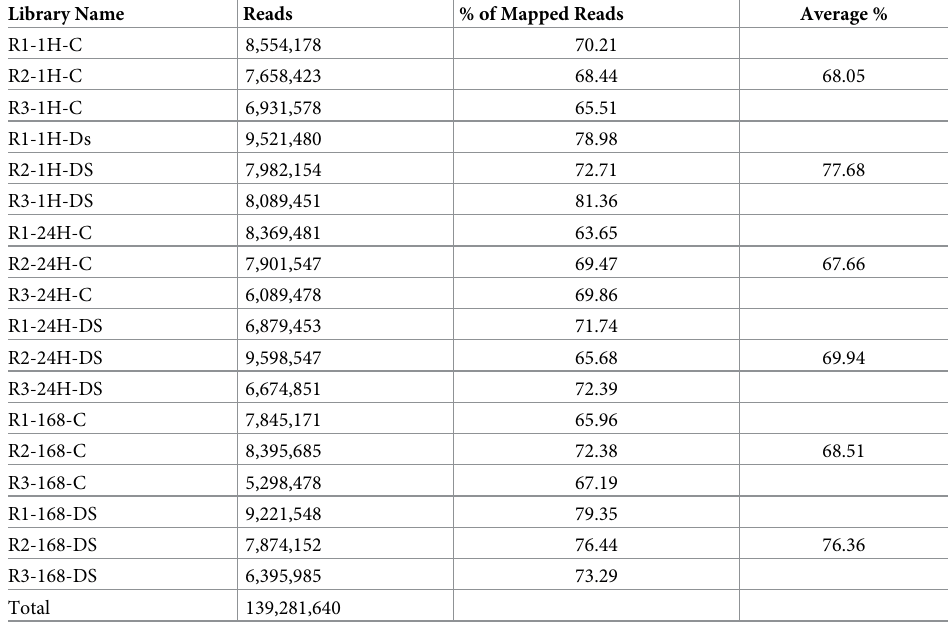
Table 1. RNA-Seq data. Summary of paired-end sequenced data, mapping and reference-based assembly determined by RNA-Seq analysis in potato tubers that were inoculated with Dickeya solani (Ds) and control (C) at time points 1, 24 and 168 h post-inoculation